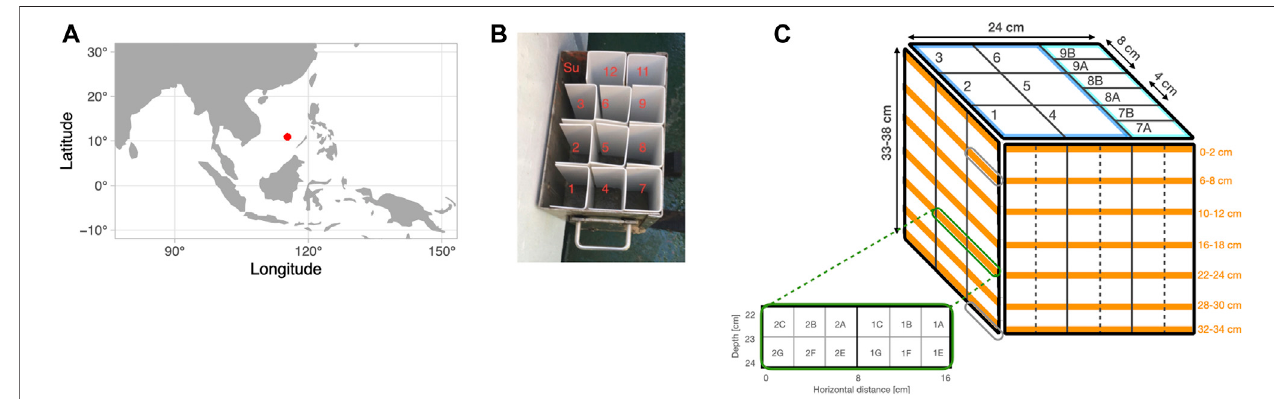
FIGURE 2 | Location and setup of the boxcore OR1-1218-C2-BC. (A) Sampling location of the boxcore in the South China Sea. (B) Photo of the setup and the plastic tubes (courtesy of Yu-Huang Chen), the sub-cores 11 and 12 are not analyzed. (C) Schematic overview of the individual samples analyzed from the boxcore. Within each sub-core, seven depth layers were sampled for radiocarbon analyses (orange layers): 0 – 2, 6 – 8, 10 – 12, 16 – 18, 22 – 24, 28 – 30 and 32 – 34 cm. A detailed overview of the sample sizes is given in Table 1 . Sub-core 1 was further used for small sample analyses (gray excerpt), and together with sub-core 2 for small- volume bulk sample measurements (22 – 23 and 23 – 24 cm, green excerpt).